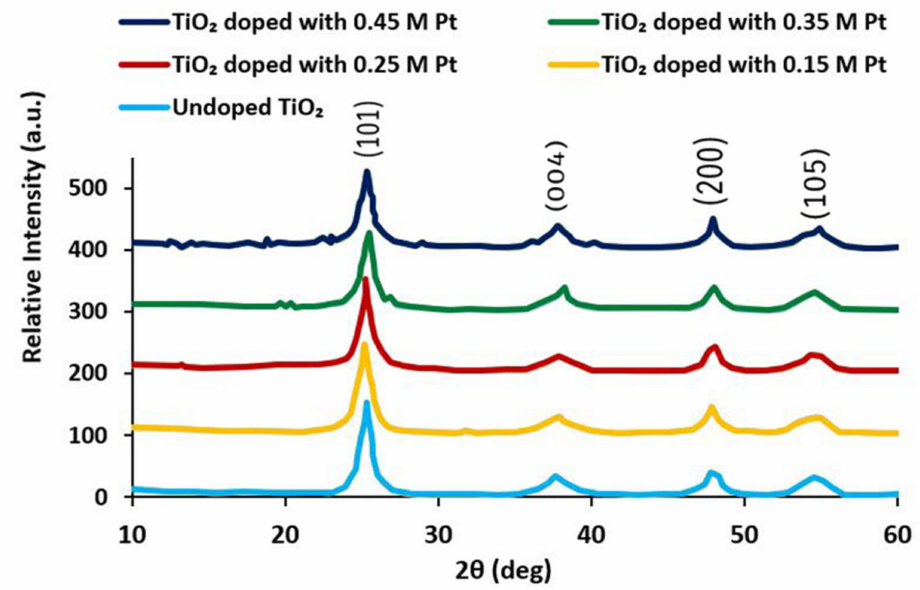
Figure 2. XRD patterns of undoped TiO 2 and Pt-doped TiO 2 at different molar concentrations; calcination temp: 400 ◦ C, calcination time: 16